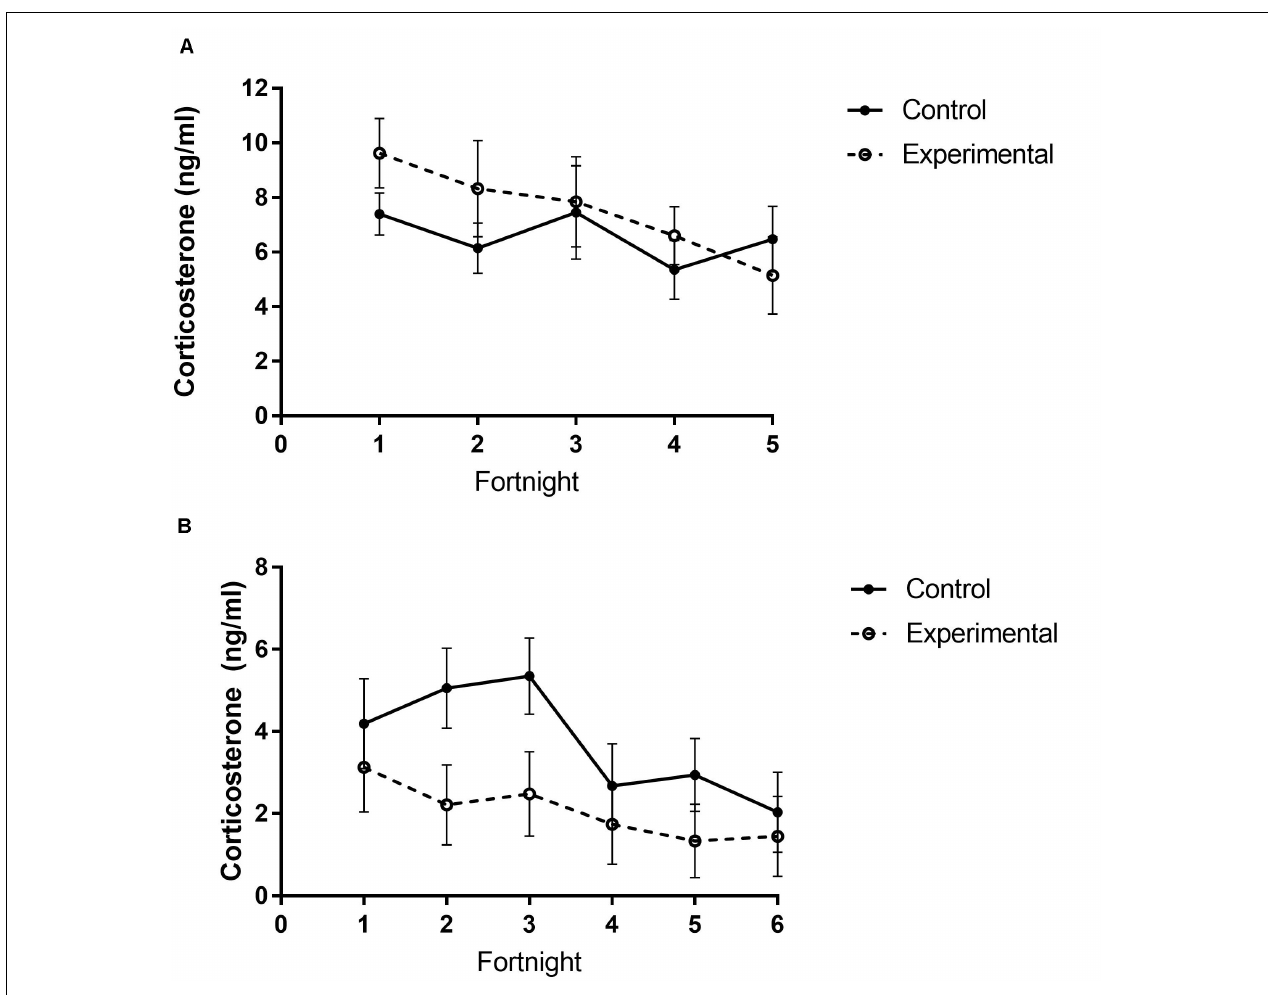
FIGURE 6 | Total plasma corticosterone of white-throated sparrows exposed to (A) low-frequency inclement weather cues (study 1) or (B) high-frequency inclement weather cues (study 2) compared to control conditions. (A) There were no differences in plasma corticosterone levels between treatment groups, but levels did significantly decrease across time. (B) Control birds had higher corticosterone levels and decreased levels across time. Points indicate mean corticosterone levels (ng/ml) and error bars indicate SEM.